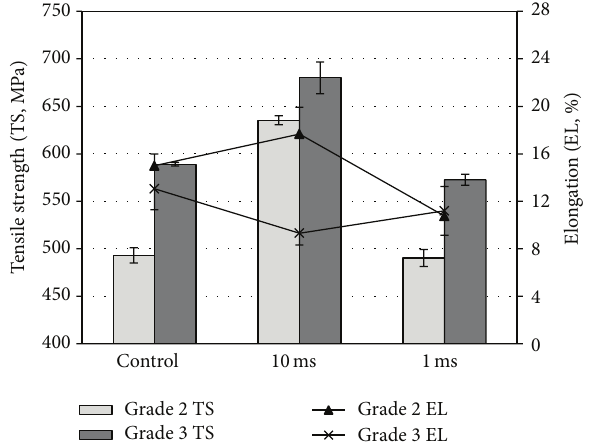
Figure 7: Hardness depth profiles from cast surface for control specimens (grade 2: black solid line, grade 3: red solid line) and specimens laser-treated with several emission currents (200A, 220 A, and 240 A) at a constant pulse duration (10ms) and a spot diameter (1.0mm).